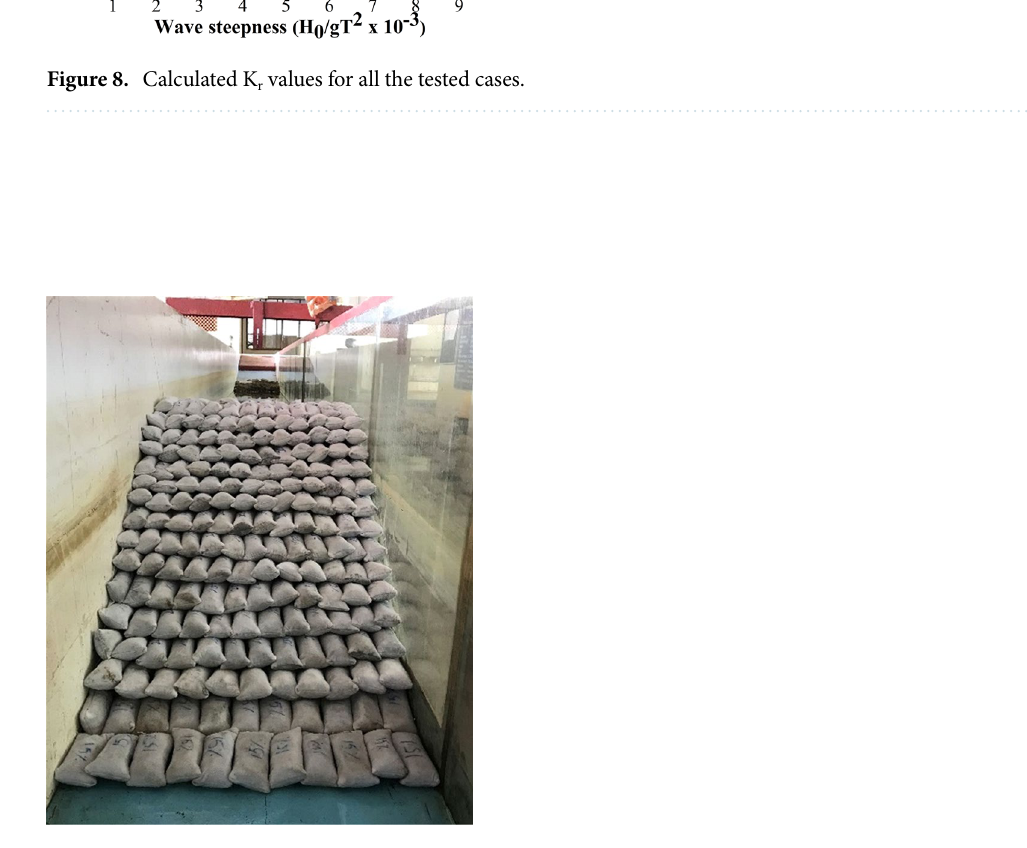
Figure 9. Image showing sand container filled with 15% cement and arranged to a single layer. Note the bulkiness of the units contributing to higher